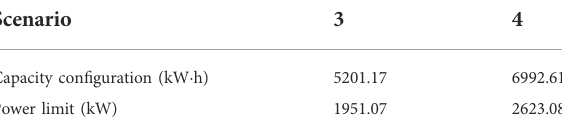
TABLE 4 Capacity con fi guration and power limit of the SESS under Spring Typical